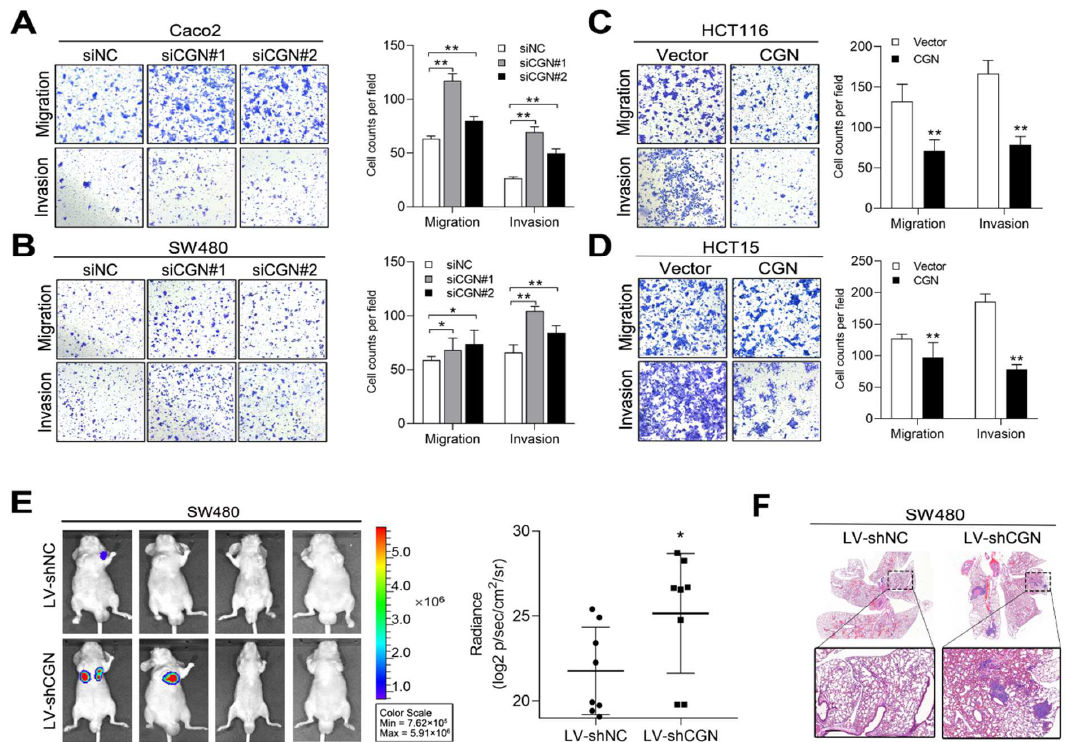
Figure 5. CGN inhibits CRC metastasis in vitro and in vivo. ( A , B ) Silencing CGN expression by siRNAs promoted migration and invasion in Caco2 ( A ) and SW480 ( B ) cells. ( C , D ) Overexpression of CGN inhibited migration and invasion in HCT116 ( C ) and HCT15 ( D ) cells. ( E ) Bioluminescent images and radiance values of mice ( n = 8) injected with SW480 cells infected with lentiviral shCGN (LV-shCGN) or negative control (LV-shNC). ( F ) Representative H&E staining images of lung tissue sections from the indicated groups. Scale bars represent 500 μm. * p < 0.05, ** p < 0.01 by the Student’s t -test.